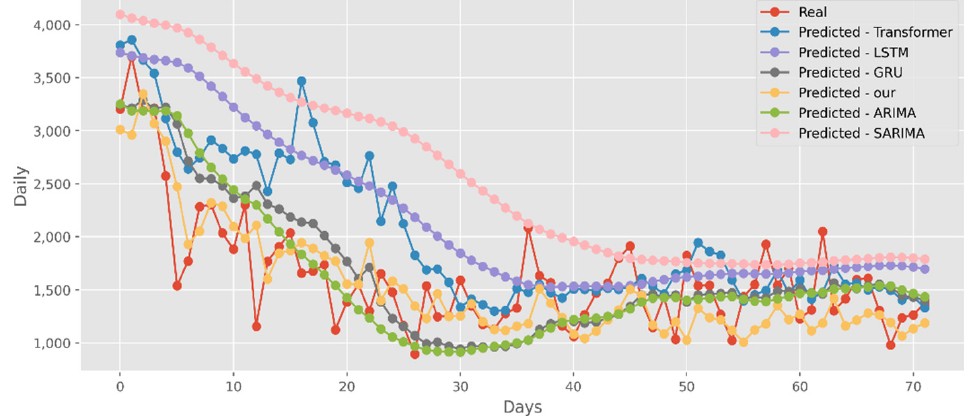
Figure 13. Comparison of COVID ‐ 19 prediction models of cases in NY.